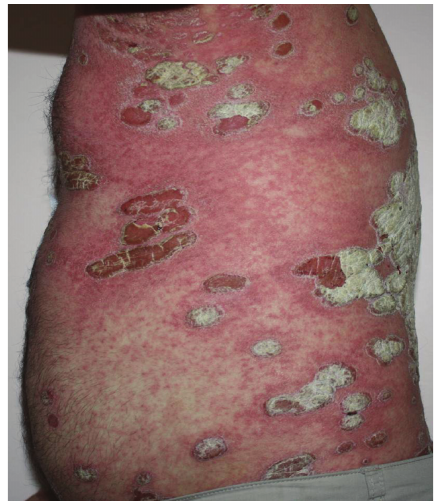
Figure 2: Generalized erythoderma characterized by tiny pustules which has developed 4 days after the second injection.